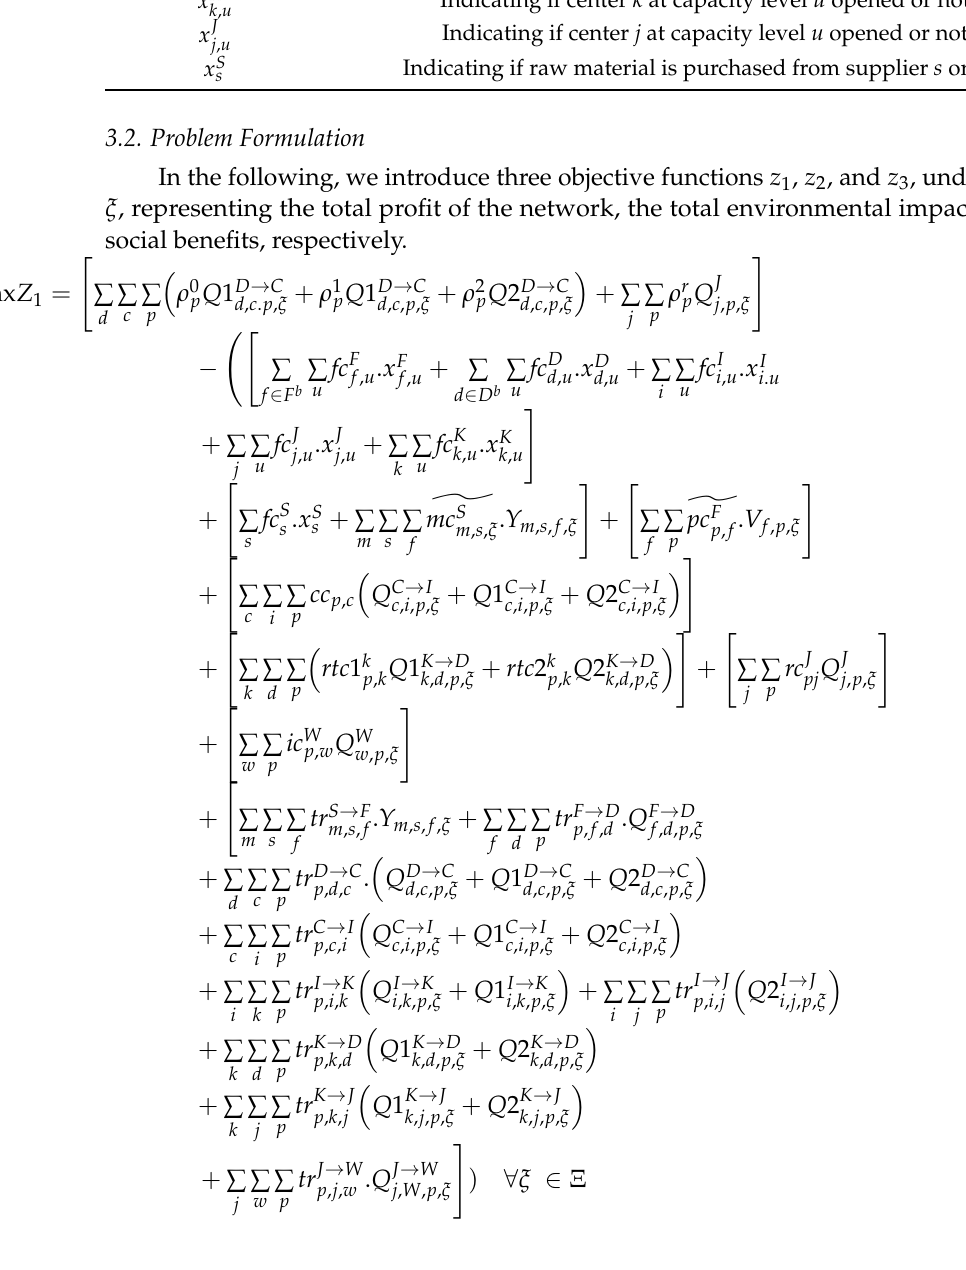
Table 2. Cont. Quantity of retread-2 tire p shipped from center k to d under scenario ξ Q 2 K → D k , d , p , ξ Quantity of retread-1 tire p shipped from center k to j under scenario ξ Q 1 K → J k , j , p , ξ Quantity of retread-2 tire p shipped from center k to j under scenario ξ Q 2 K → J k , j , p , ξ Total quantity of recycled tire p at recycling center j under scenario ξ Q J j , p , ξ Quantity of tire p shipped from center j to w under scenario ξ Q J → W j , W , p , ξ Q W Total quantity d ∈ D b f tire p incinerated at center w under scenario ξ w , p , ξ Binary variables: x F Indicating if center f at capacity level u opened at location f ∈ F b or not f , u x D Indicating if center d at capacity level u opened at location d ∈ D b or not d , u Indicating if center i at capacity level u opened or not x I i , u Indicating if center k at capacity level u opened or not x K k , u Indicating if center j at capacity level u opened or not x J j , u x S s Indicating if raw material is purchased from supplier s or